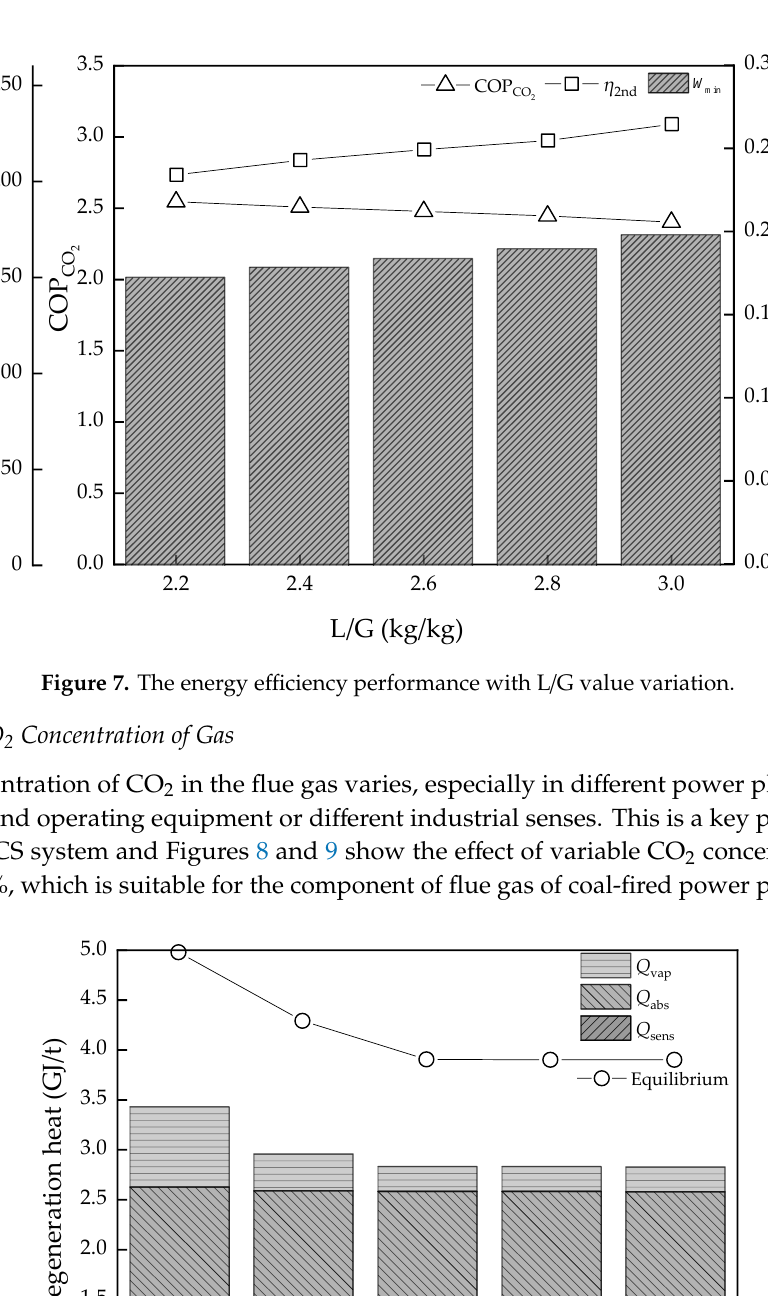
Figure 9. The energy efficiency performance with the CO 2 concentration variation. 3.3. .Effect of Desorption Temperature The desorption temperature is an important factor of solvent properties and operating conditions. Figure 10 and Figure 11 show the result of the energy performance with different desorption temperatures. Attention should be given to the desorption temperature as the final stage temperature in the equilibrium model. The Q sens and Q abs have a slight increase, while the Q vap decreases due to the P CO2 growth. Then, the regeneration heat of the thermodynamic method and equilibrium model both have a growth trend and the equilibrium model is more obvious from 3.75 to 4.32 GJ/t, while the thermodynamic cycle is from 2.82 to 2.85 GJ/t in the ideal condition. The COP CO2 and η 2nd both have a decreasing trend, but it is not obvious, from 2.48% to 2.43% and from 26.1% to 24.4%, respectively. Compared to the effect of the thermodynamic properties of MEA solvents, such